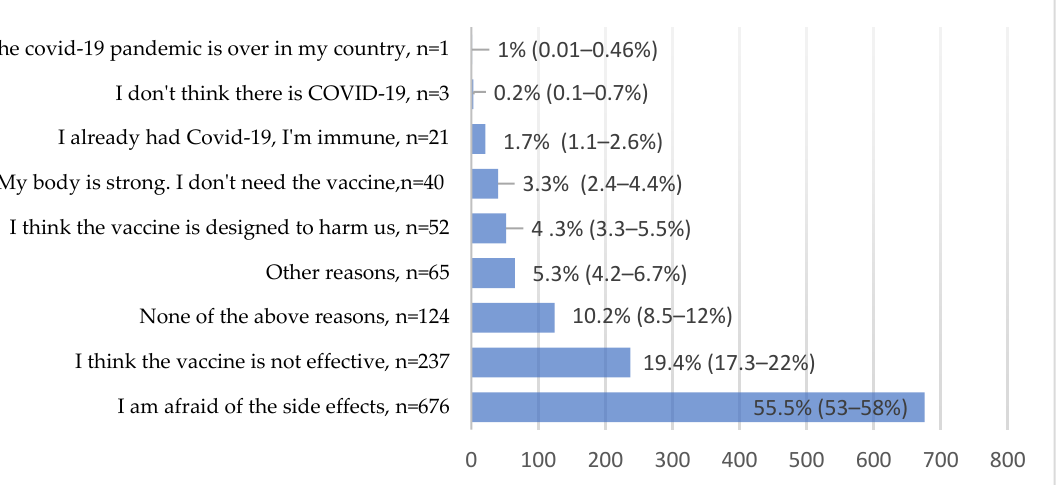
Figure 2. Reasons for COVID-19 vaccine hesitancy with confidence intervals.